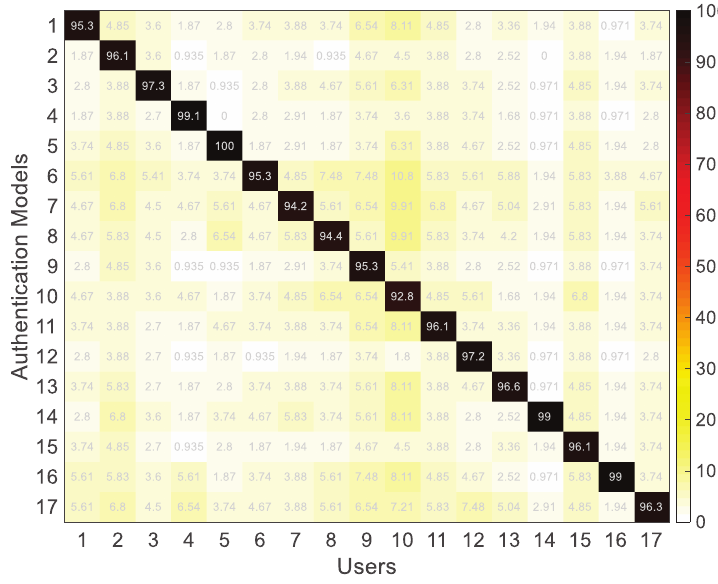
Figure 10. The fusion matrix of overall accuracy.